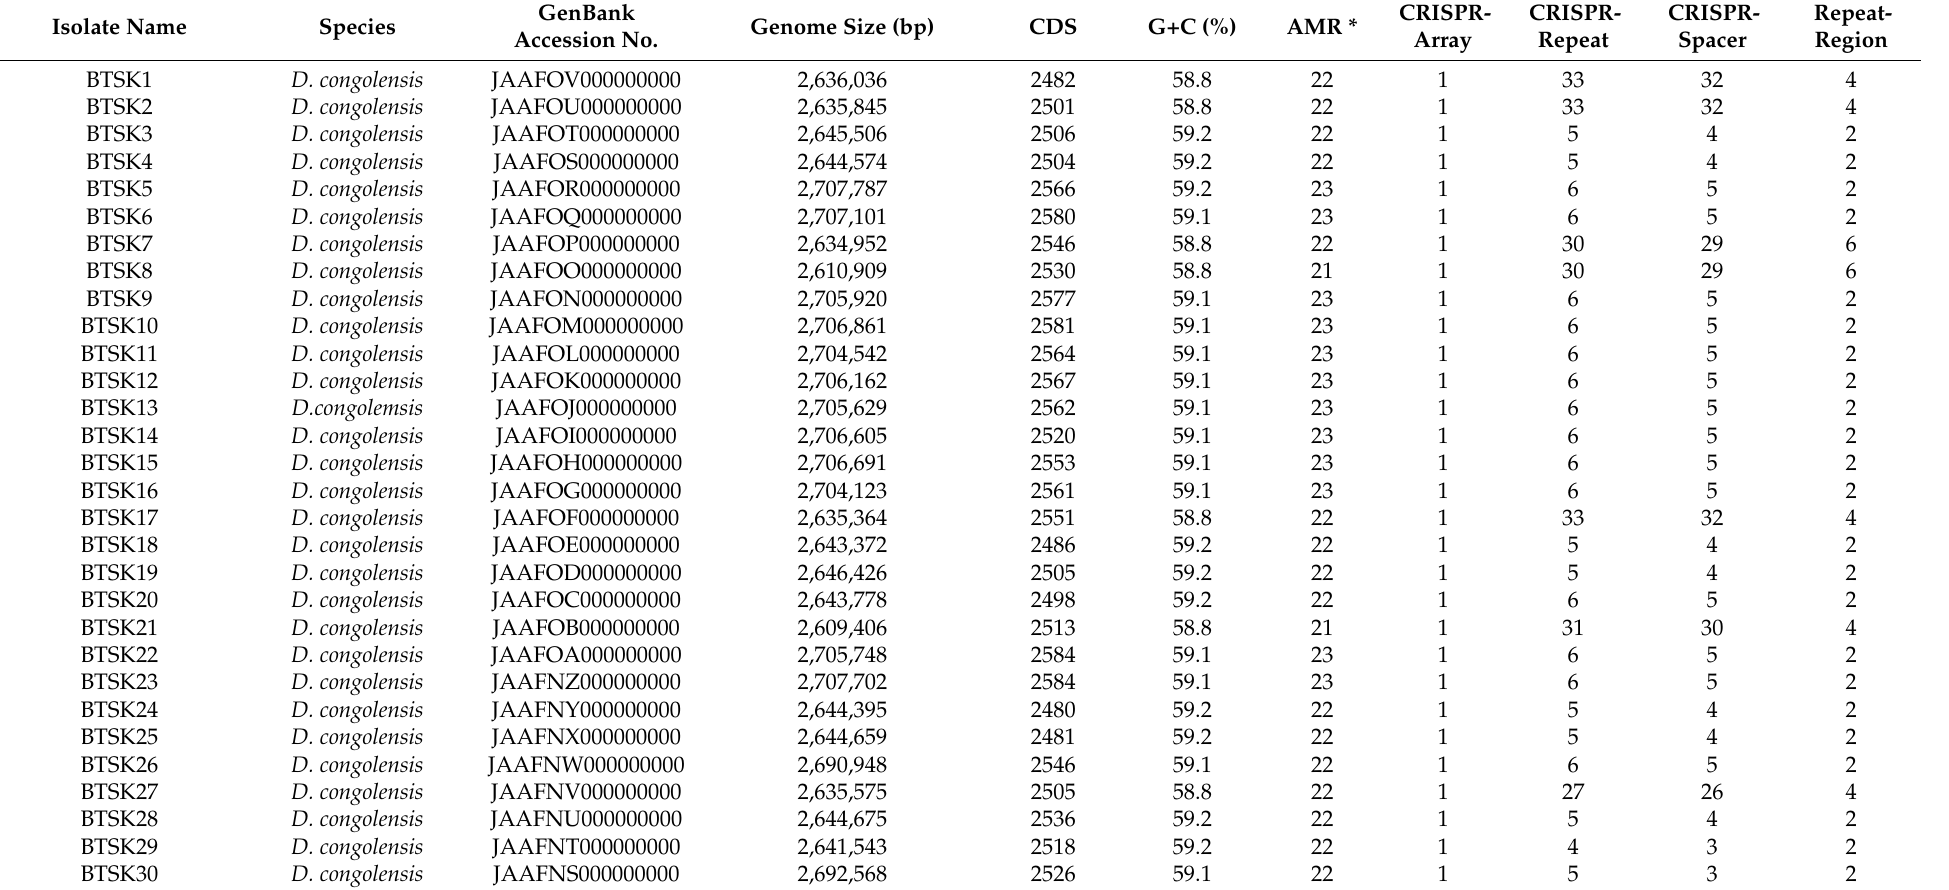
Table 1. Summary statistics for 40 draft genome assemblies of D. congolensis isolated from acute cases of dermatophilosis on the Island of St. Christopher in the West